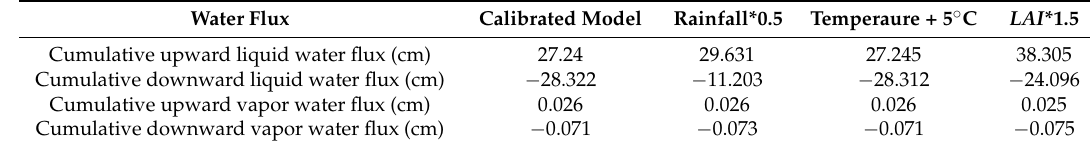
Table 6. The cumulative flux of liquid water and water vapor during climate and LAI